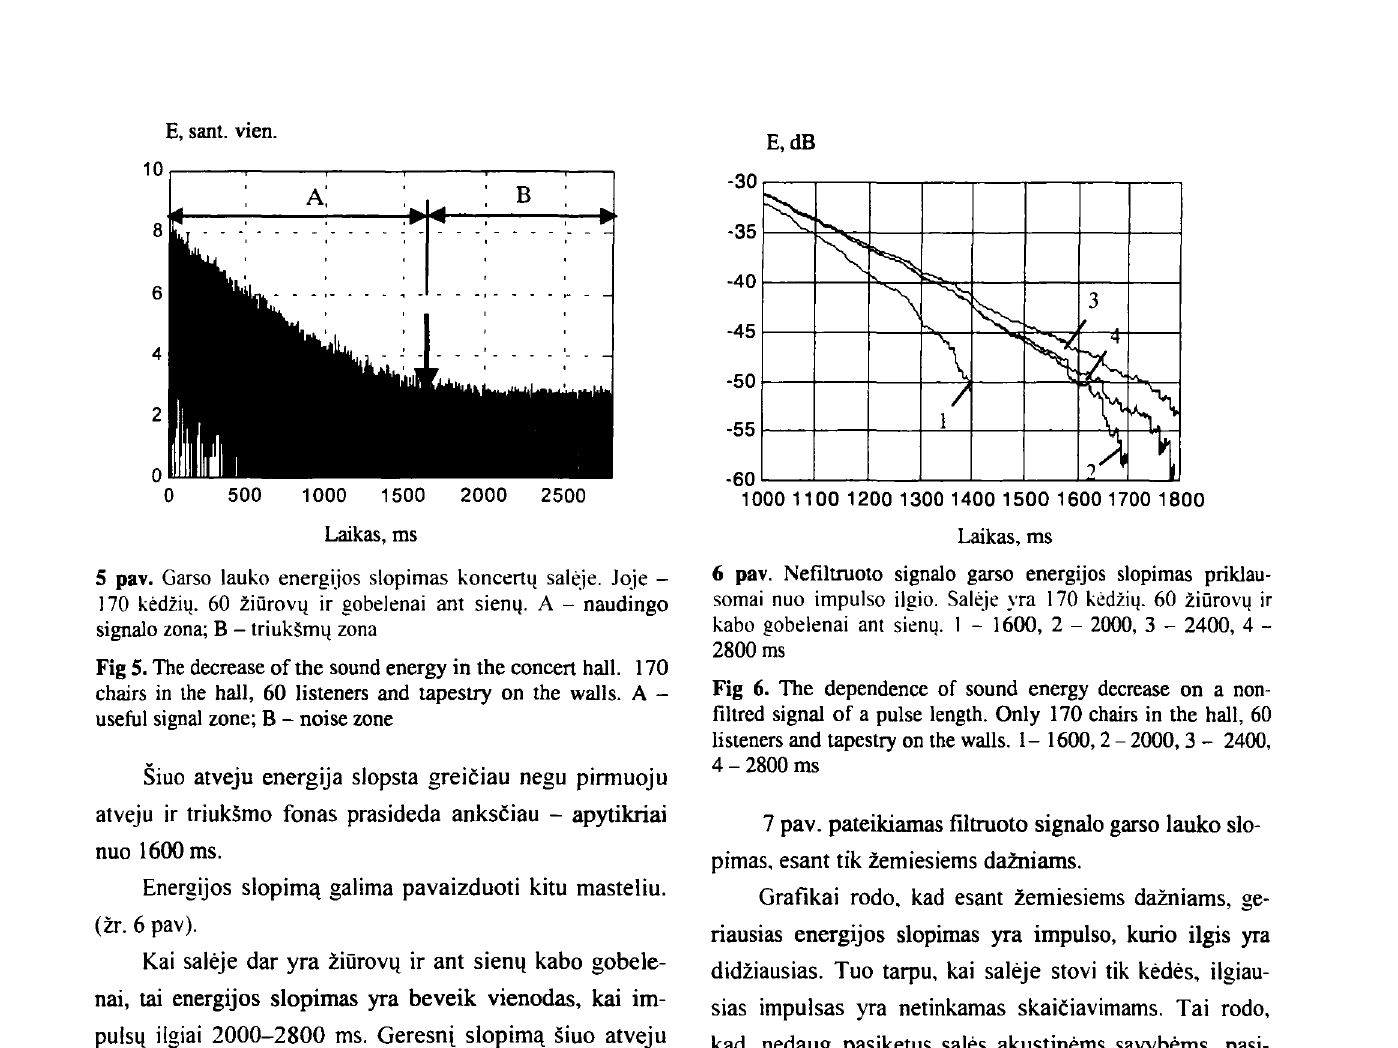
2800 ms Fig 6. The dependence of sound energy decrease on a non filtred signal of a pulse length. Only 170 chairs in the hall, 60 listeners and tapestry on the walls. 1- 1600, 2 - 2000, 3 - 2400, 4-2800 ms 7 pav. pateikiamas filtruoto signalo garso lauko slo pimas. esant tik zemiesiems